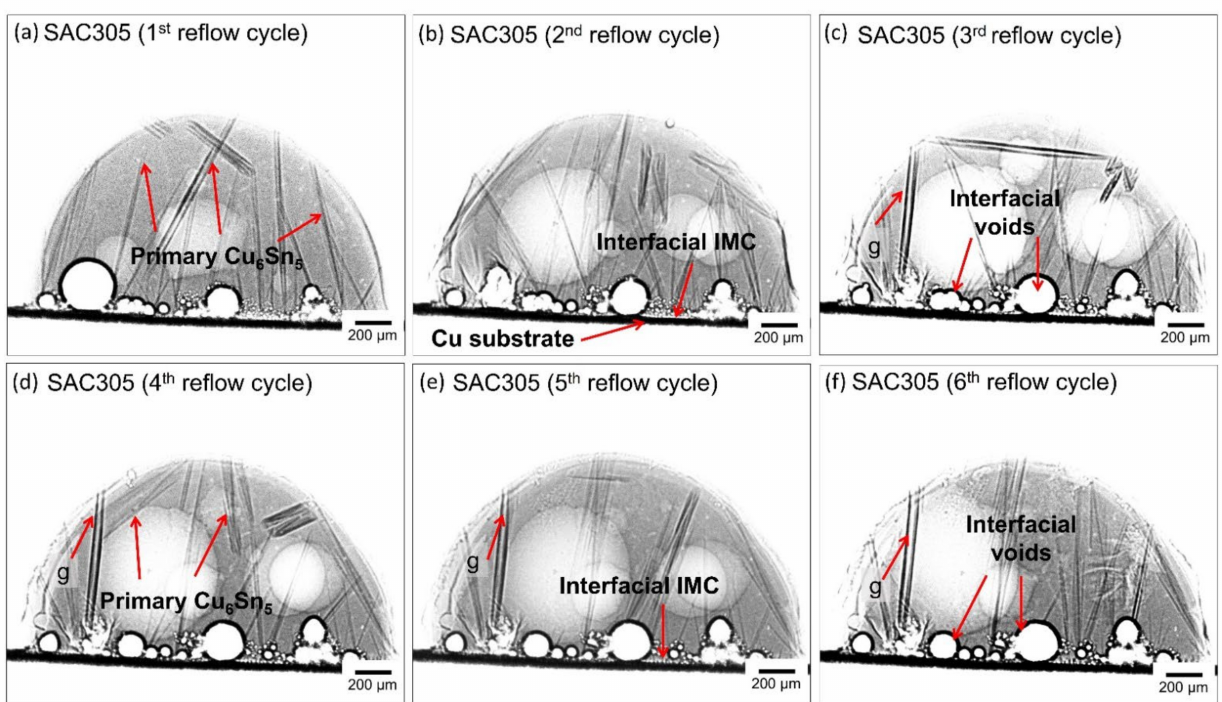
Figure 6. Synchrotron radiation images of SAC305 showing the formation of primary Cu 6 Sn 5 IMC for multiple cycles of reflow soldering.